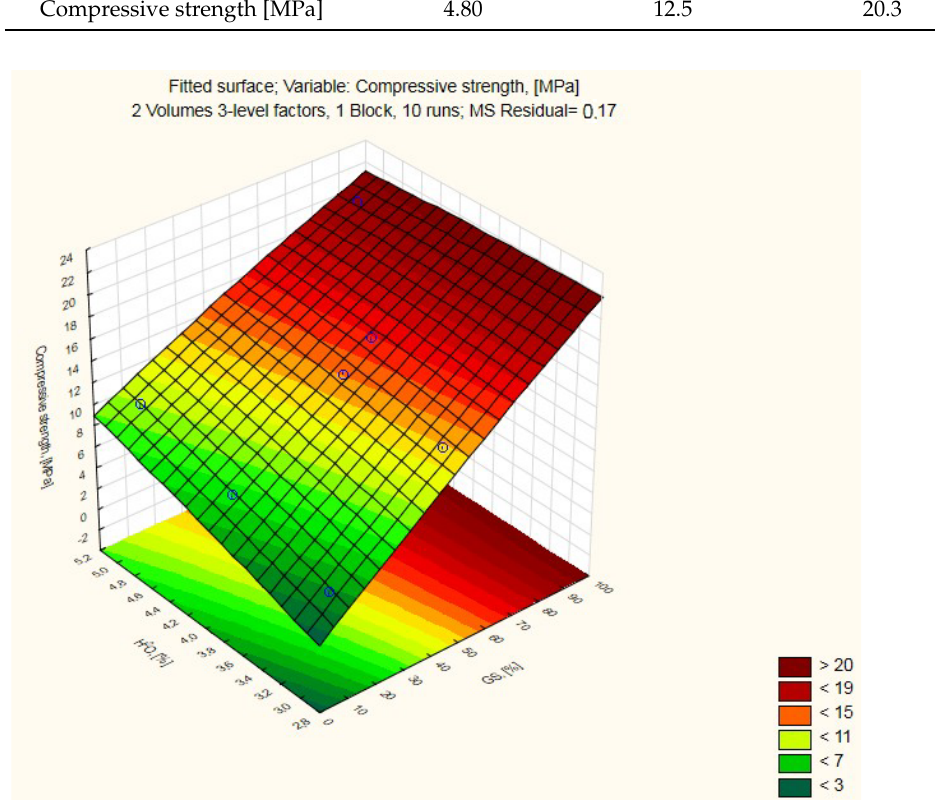
Figure 8. Compressive strength diagram for autoclaved brick modified with glass sand (GS) as a substitute for quartz sand (QS) in the presence of water (H 2 O).